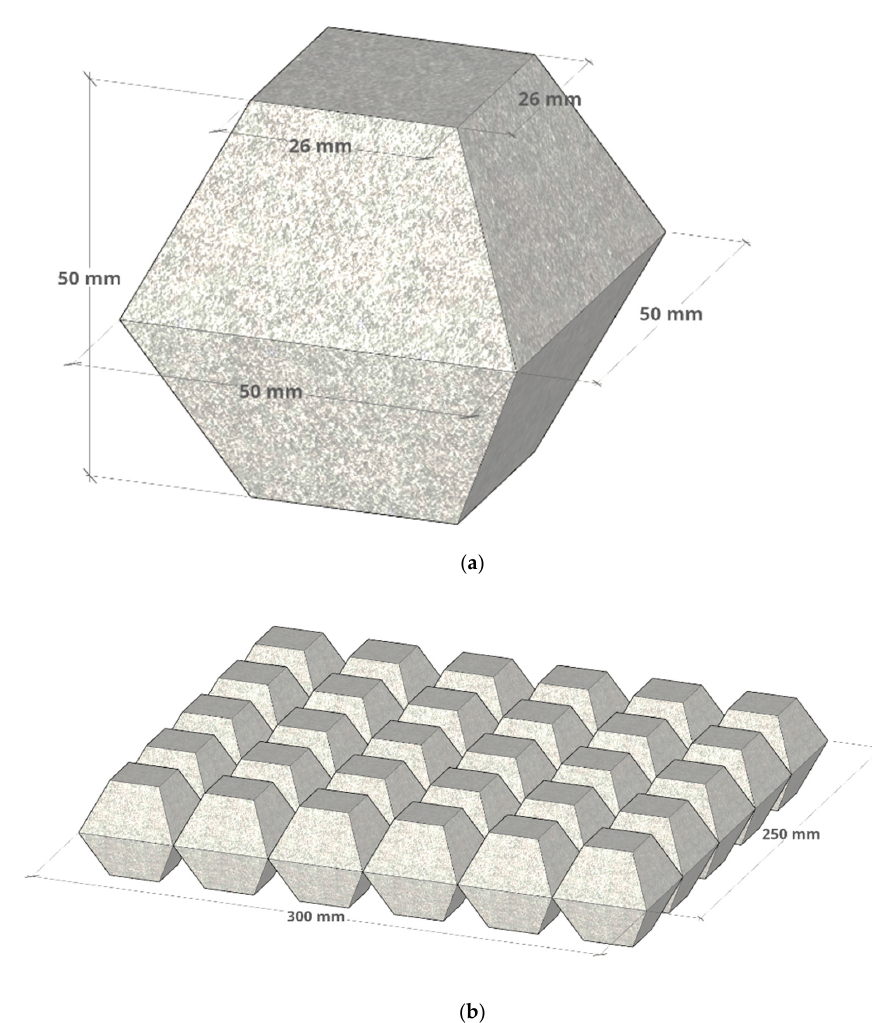
Figure 2. A drawing of the ACM model. ( a ) drawing of a single block, ( b ) ACM with a configuration of 5 × 6 and the flow is set along the long edge ( W = 0.25 m, L = 0.3 m, H = 0.05 m and H e = 0.0338 m).